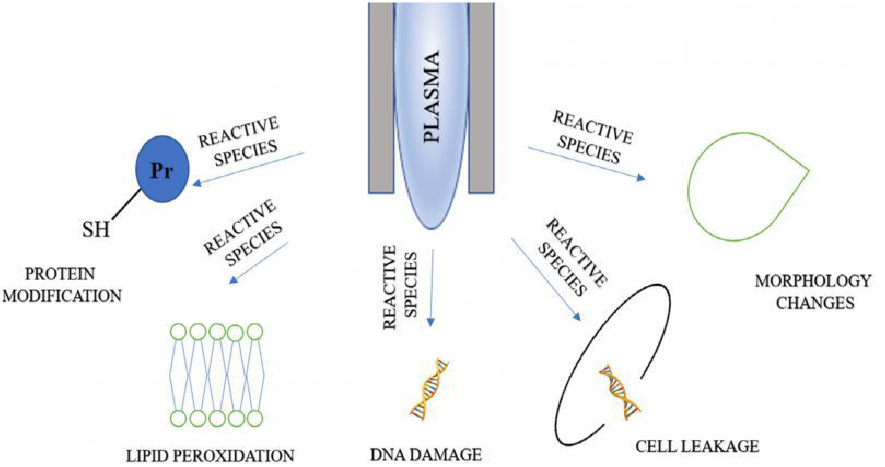
Figure 5. Mechanisms of microbial inactivation with plasma agents [168].